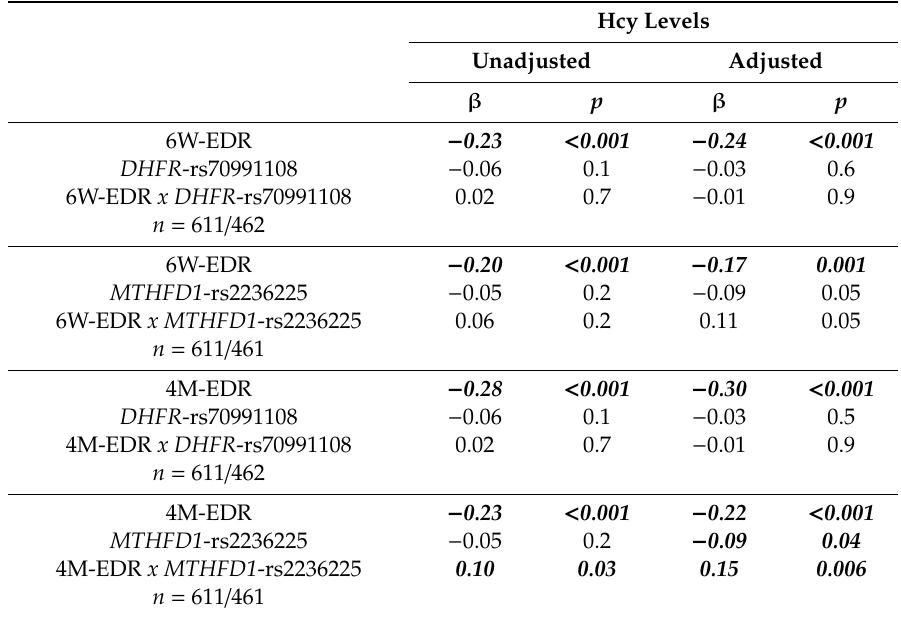
Assessment of gene–environment interactions between DHFR -rs70991108